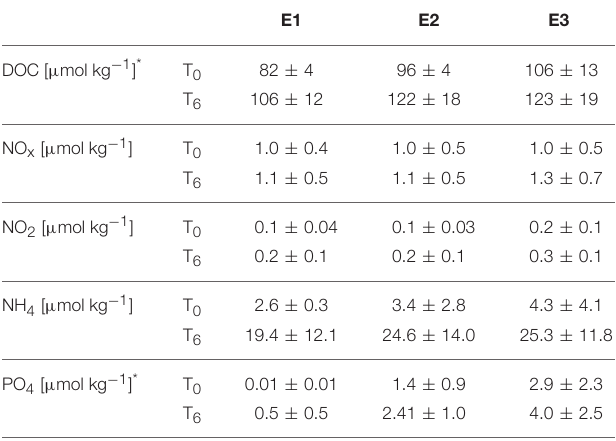
TABLE 2 | Initial (T 0 ) and final (T 6 ) DOC and nutrient concentrations averaged over all incubations ( ± standard deviation) for the three “eutrophication” treatments: “E1” (natural organic loading), “E2” (double labile organic loading), “E3” (triple labile organic